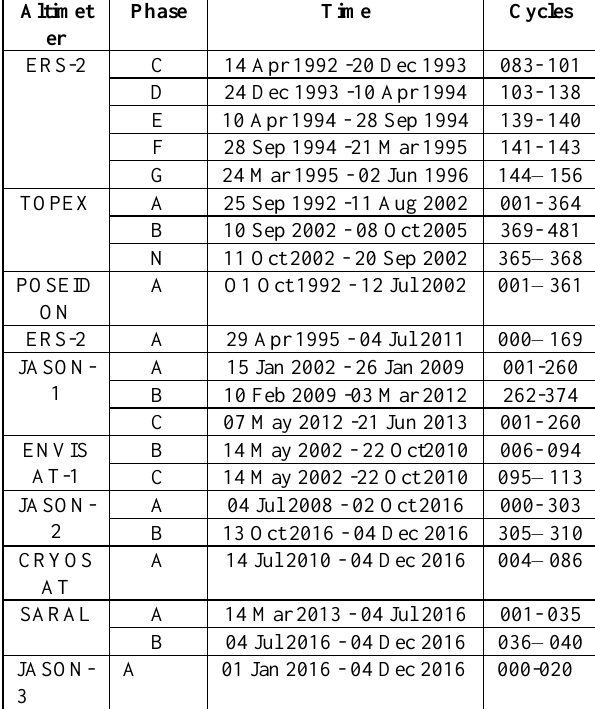
Table 1. Available data provided in Radar Altimeter Database System (RADS, 2017). Figure 4. Formation of wind waves (Oceanography, 2015) 2.5 Monsoon Monsoon is a type of season that occurred most of the time in south and east of Asia including Malaysia. Theoretically, monsoon is occurred due to the movement of the air from the sea and land. Two important factors are applied in this theory which is density and pressure. During cold season, the land experienced lower temperature than the ocean, therefore the density and the pressure of the land is higher, resulting in wind- blown from land to sea. In hot season, the same situation will be reversed, and monsoon is occurred with the existence of seasonal change of wind